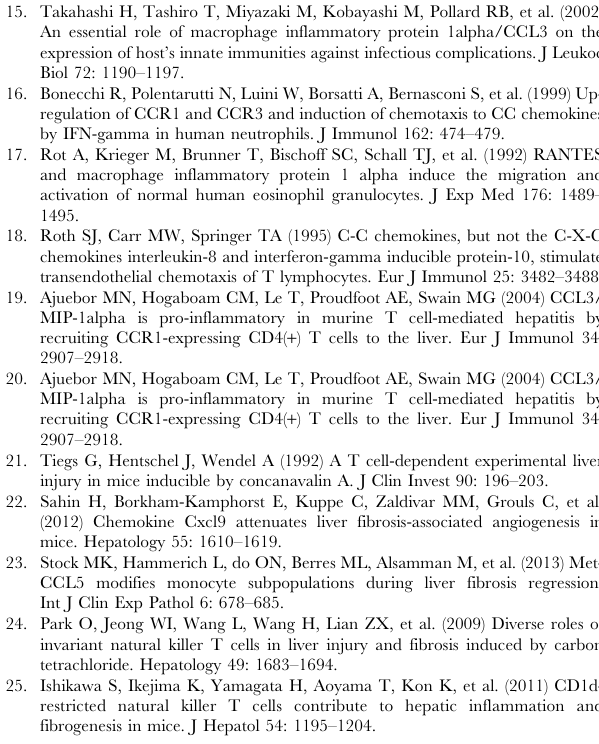
Figure S1 CCL3 is involved in metabolic disease. CCL3 2 / 2 mice exhibits significantly lower hepatic and serum